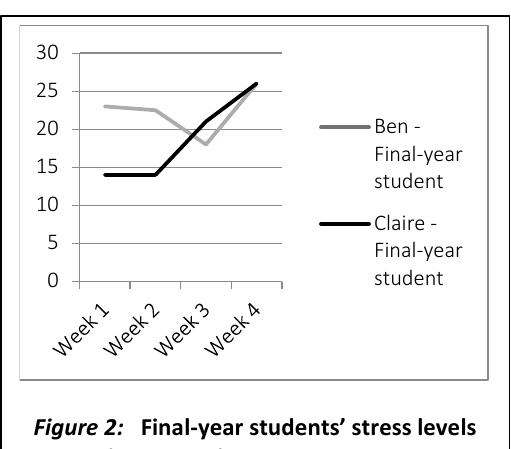
Figure 2: Final-year students’ stress levels (1-4 weeks) using PSS